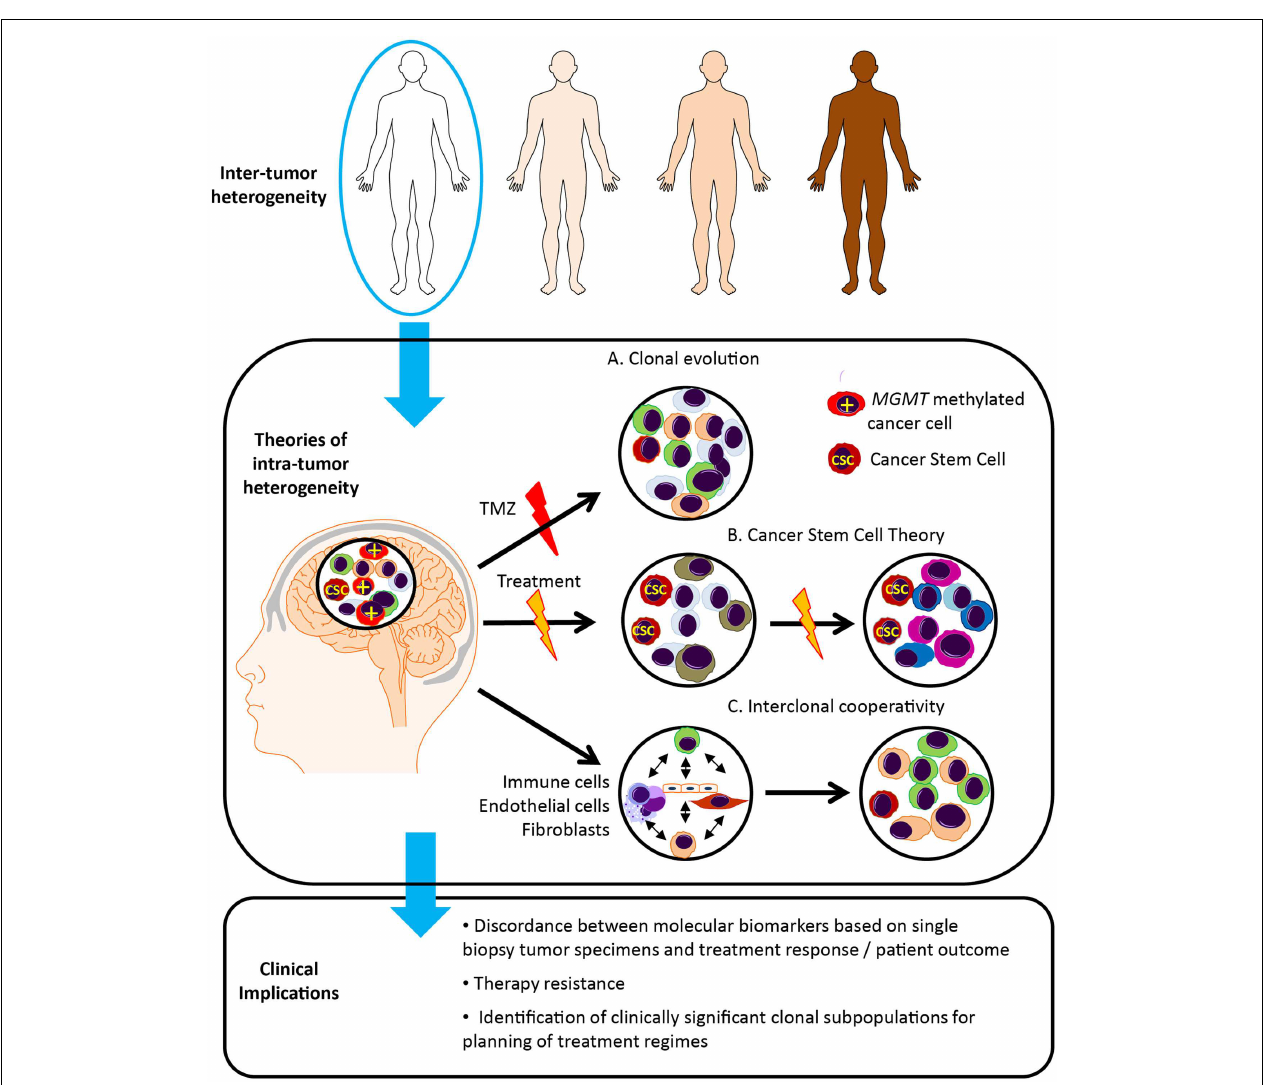
TMZ treatment. (B) In contrast, according to the cancer stem cell theory, only a single subset of cells, known as cancer stem cells (CSC), possess the ability to self-renew, continuously proliferate and give rise to clones of variable genetic profiles, and are inherently resistant to therapy. (C)The theory of interclonal cooperativity suggests that tumor evolution and heterogeneity is promoted by interactions between tumor cell clones and their microenvironment, with immune/stromal factors influencing malignant progression. Significant clonal diversity within tumor specimens may explain the failure of molecularly targeted therapies in glioblastoma patients.